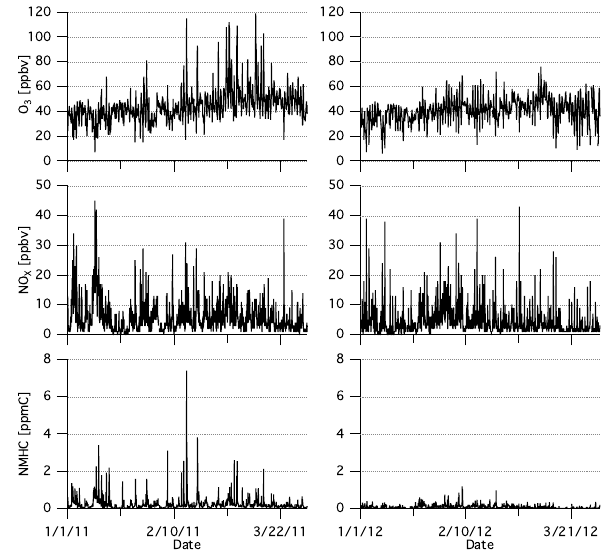
Figure 2. Time series of O 3 , NO x , and NMHC at Boulder South Road (BSR) for the period January through March during 2011 and